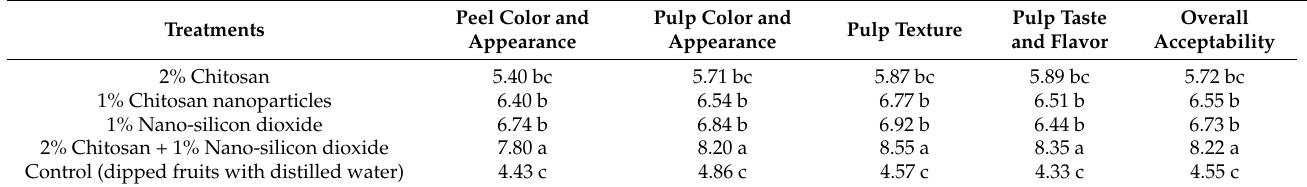
Table 3. Hedonic scale rating for various sensory attributes as a mean of ‘Tommy Atkins’ mangoes from two seasons, after stored for 5 days as the marketing period. Peel Color and Pulp Color and Treatments Appearance